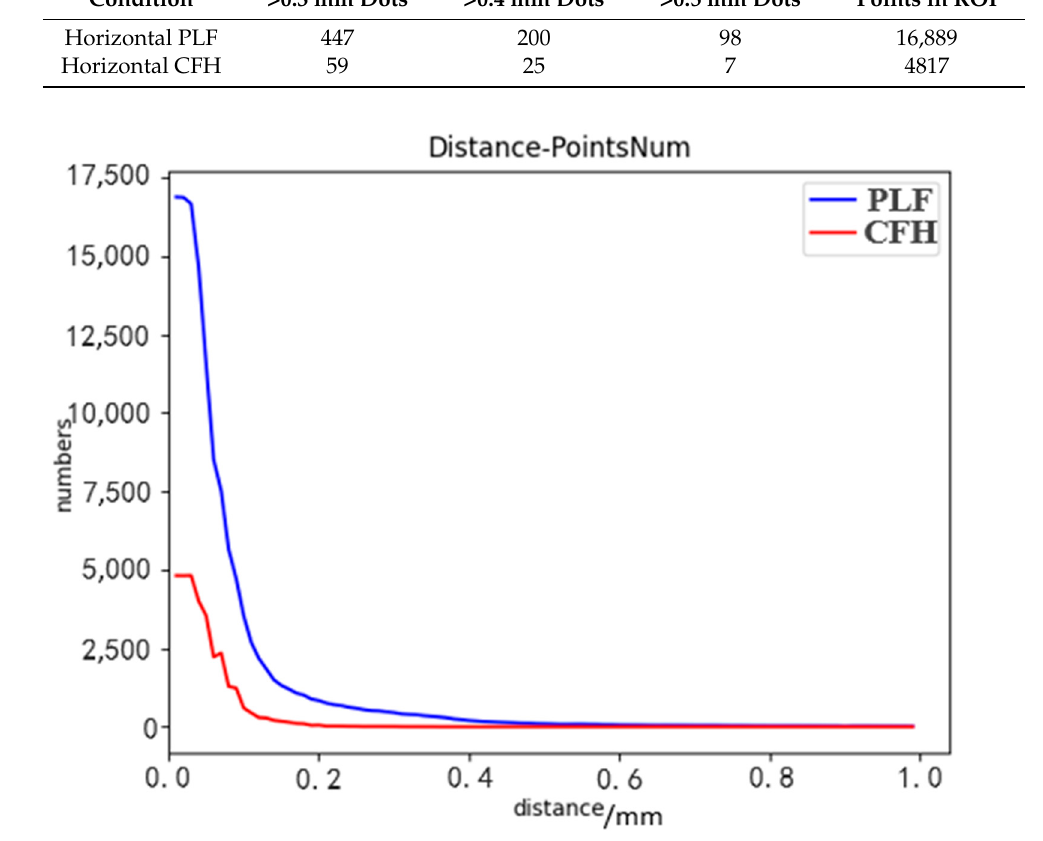
Figure 17. Horizontal comparison picture.